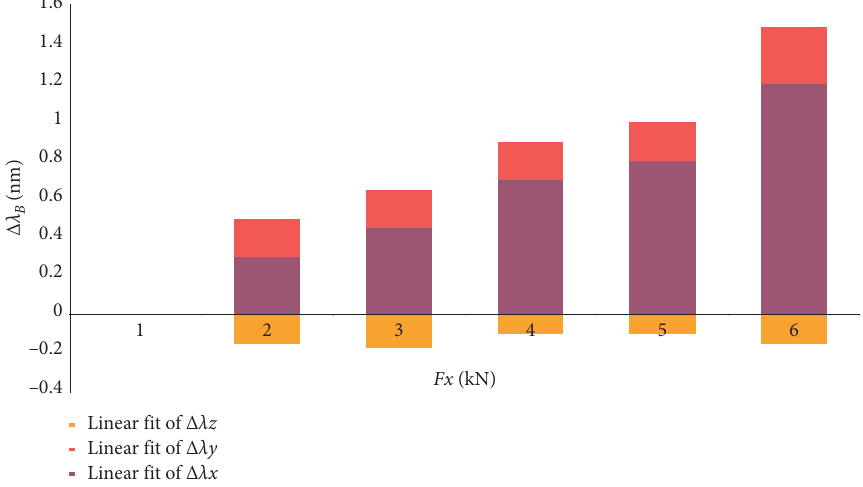
Figure 2: Wavelength of fiber Bragg grating during experimental